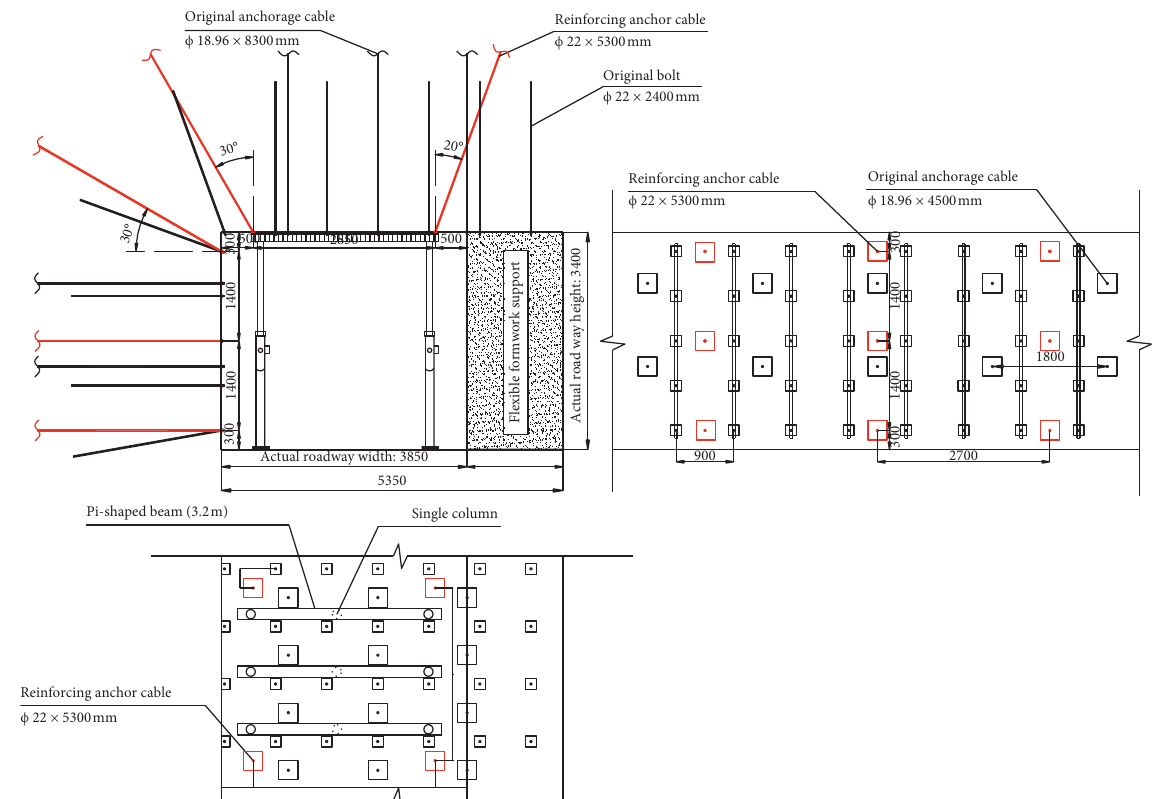
Figure 8: The schematic diagram of cable reinforcement of W1319 intake entry.